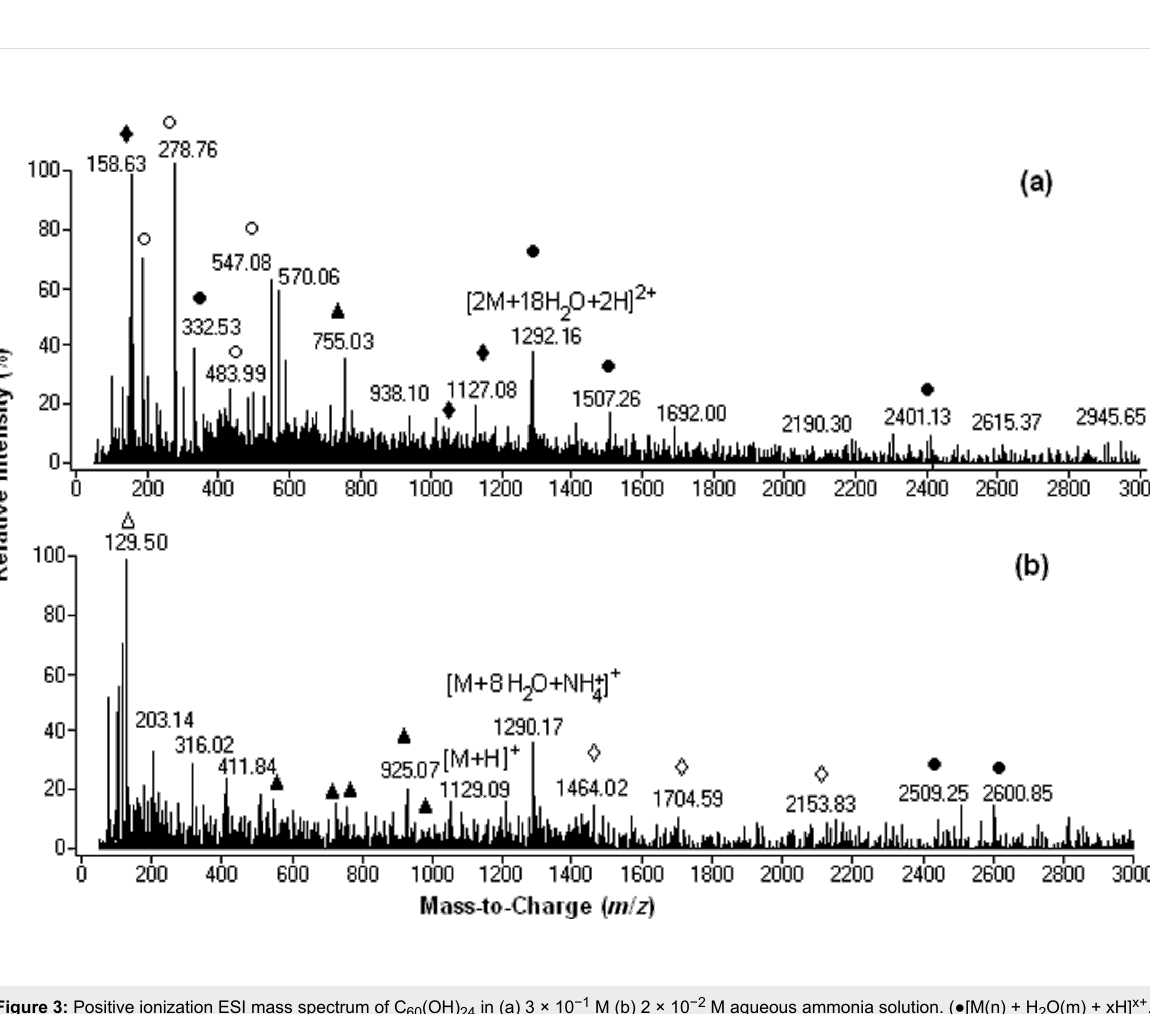
Figure 3: Positive ionization ESI mass spectrum of C 60 (OH) 24 in (a) 3 × 10 − 1 M (b) 2 × 10 − 2 M aqueous ammonia solution. ( ● [M(n) + H 2 O(m) + xH] x+ , ▲ [M(n) − OH(m) + xH] x+ , ♦ [M(n) − H 2 O(m) + n NH 3 + xH] x+ , ○ [M(n) − H 2 O(m) + xH] x+ , ∆ [M(n) − OH(m) + yNH 4+ + xH] (x+y)+ , ◊ [M(n) + H 2 O(m) + n NH 3 + xH] x+